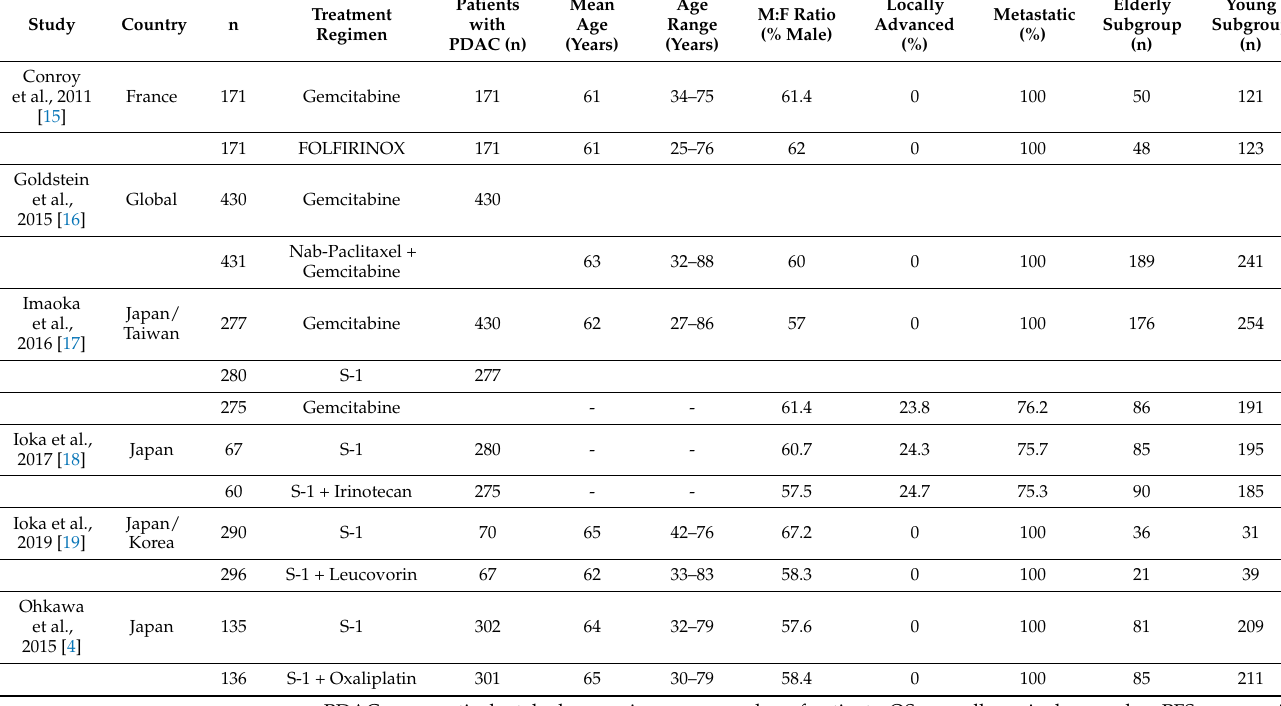
Table 1. Summary of studies including authors, country, treatment, number of patients overall and by subgroup, age, sex, and stage of disease.